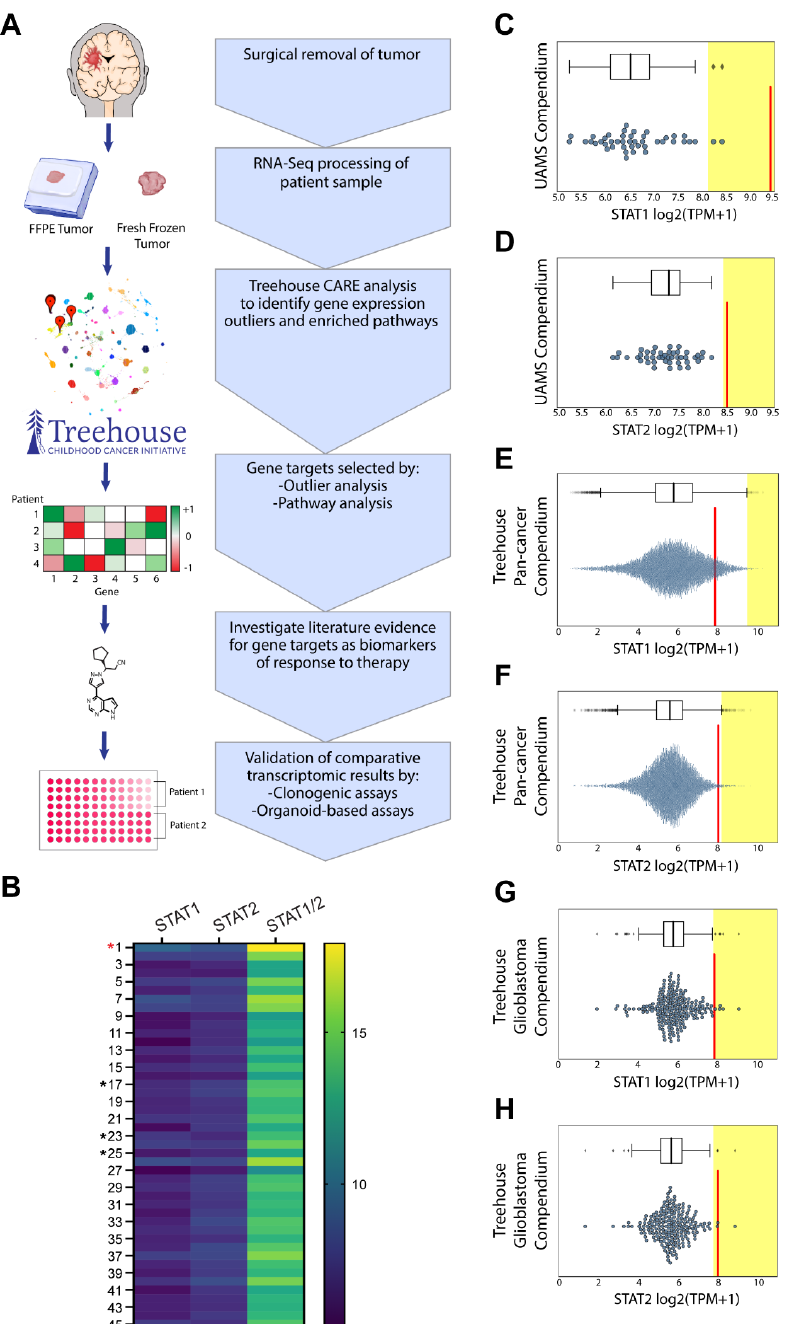
Figure 3. Comparative transcriptomic analysis of Li Fraumeni glioblastoma elucidates novel tumor characteristics. ( A ) Comparative transcriptomic ex vivo functional validation pipeline is described. ( B ) Heatmap identifying STAT1 and STAT2 expression from 45 grade III and grade VI astrocytoma